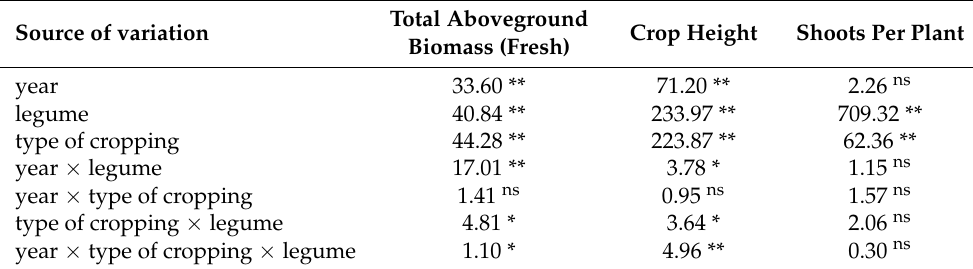
Table 6. Test of fixed effects for LMM analyses for legumes traits analyzed in sunflower legumes intercropping.